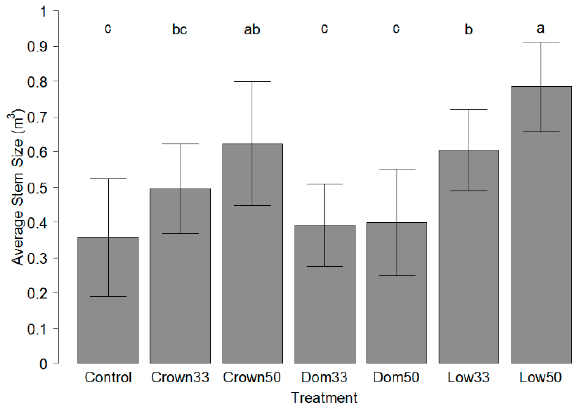
Figure 5. Average merchantable stem size for all treatments and control including error bars (one standard deviation). Letters above the bars indicate statistically significant differences between treatments and control.